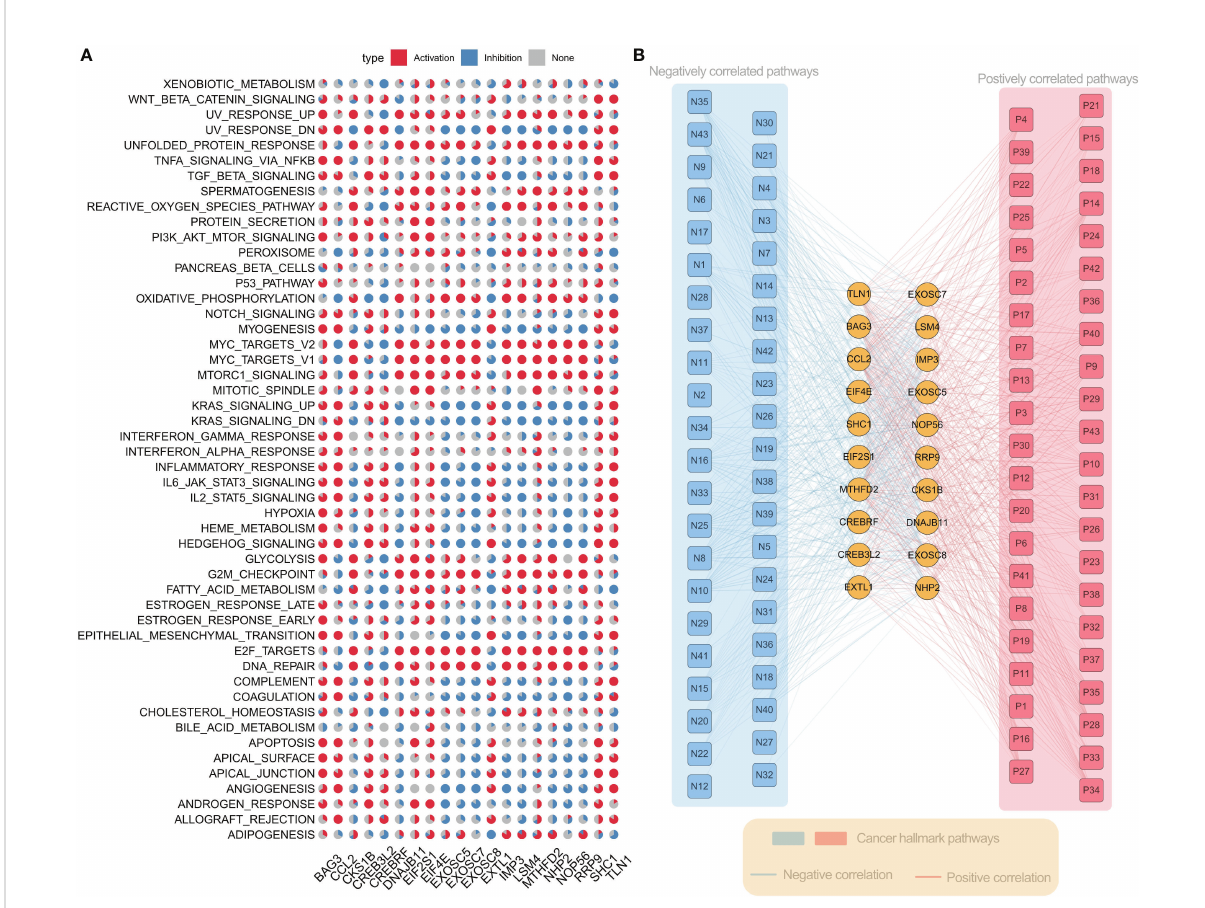
FIGURE 4 Er stress factors are associated with the activation or inhibition of oncogenic pathways. (A) The correlation between endoplasmic reticulum stress factor and Hallmark pathway in gastrointestinal pan-cancer. Red indicates positive correlation, while blue indicates negative correlation. The proportion of pie chart indicates the number of cancers. (B) Correlation between ER stress factors and Hallmark pathway in LIHC, with red representing positive correlation and blue representing negative correlation.